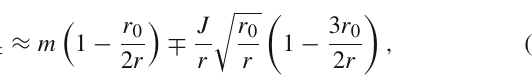
Hence, assuming that the test tops have dimensions of the order of d ∼ 10 − 2 [m], then the ratio gives of the order δ ≈ 10 − 15